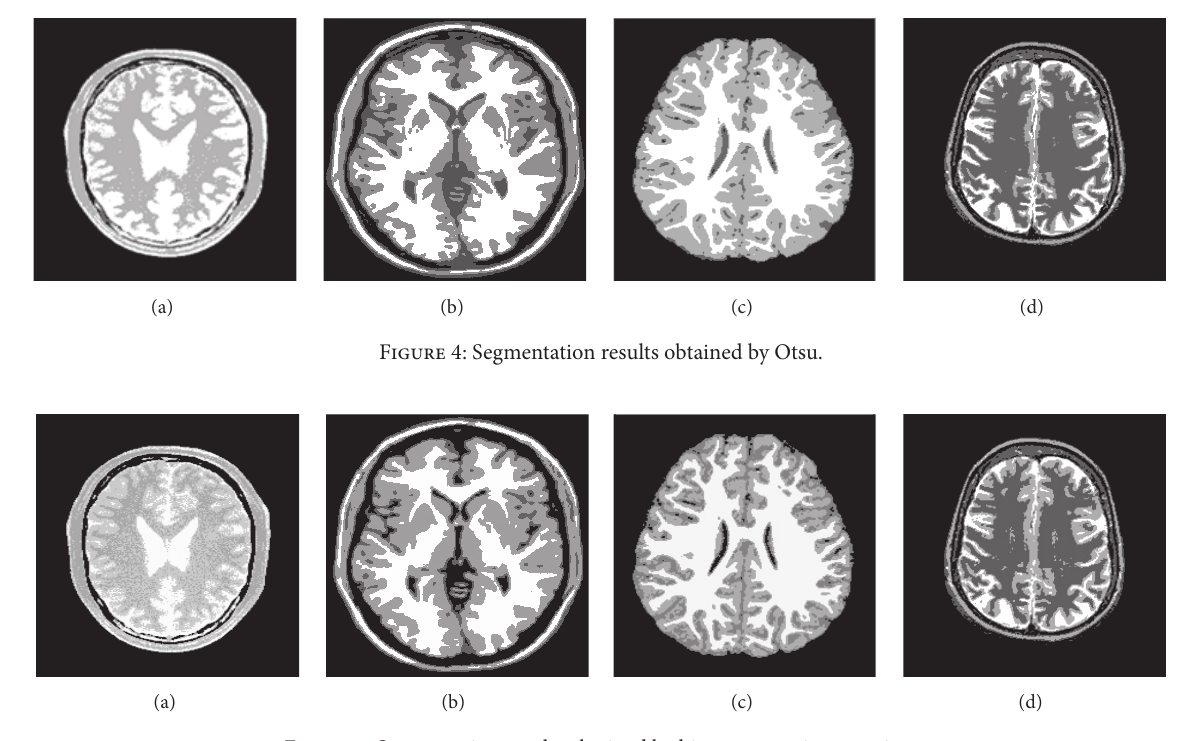
Figure 5: Segmentation results obtained by histogram region